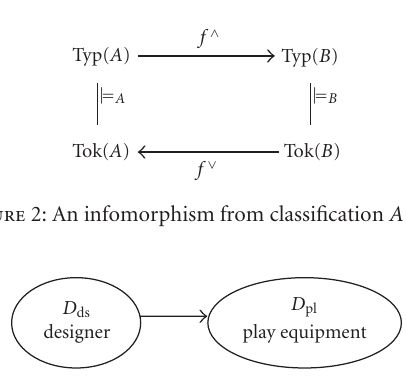
Figure 3: Conventional design process modeled by an infomor-